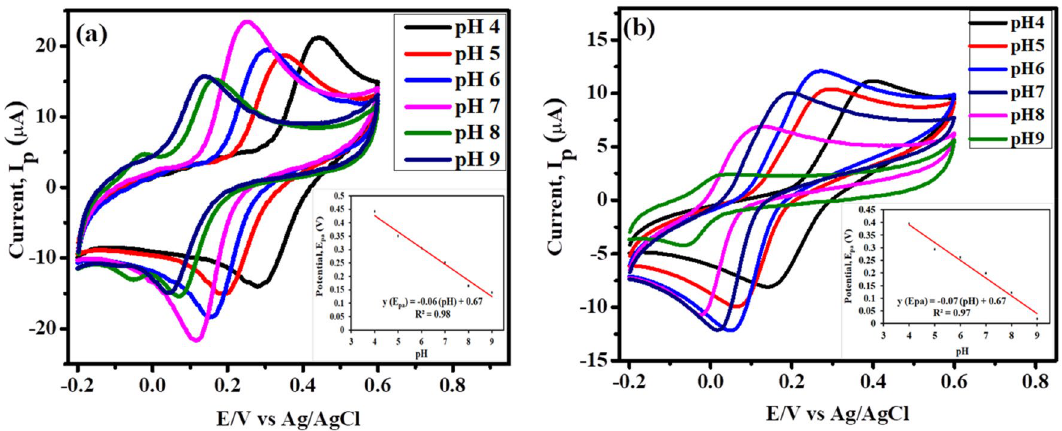
Figure 7. Effect of variable pH (4.0–9.0) solutions of ( a ) 500 µM catechol ( b ) 500 µM hydroquinone (0.1 M PBS) at CNCs/Zn-TPP/GCE electrode. Insets: Calibration plot of E pa vs. pH containing 500 µM CC and HQ.